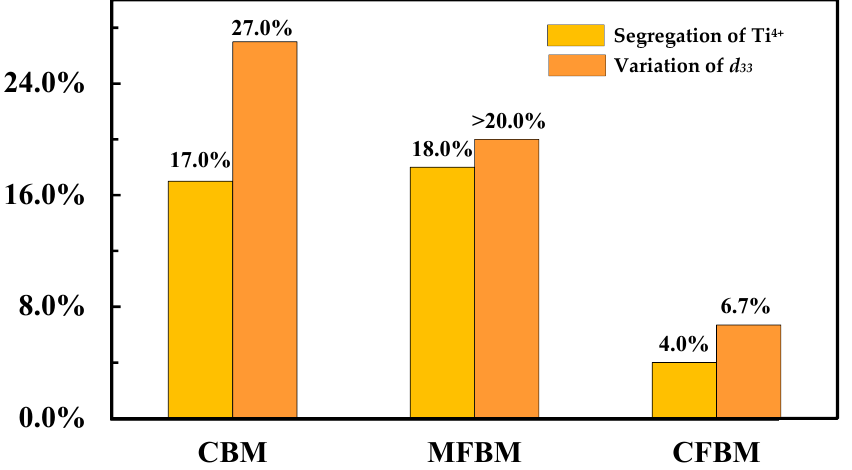
Figure 3. Compositional segregation and d 33 variation along growth direction of the PIN-PMN-PT boules grown by different modified techniques: conventional Bridgman method (CBM-left), multi- furnace Bridgman method (MFBM-middle) and continuous-feeding Bridgman method (CFBM-right). Data from refs. [50,54,55].